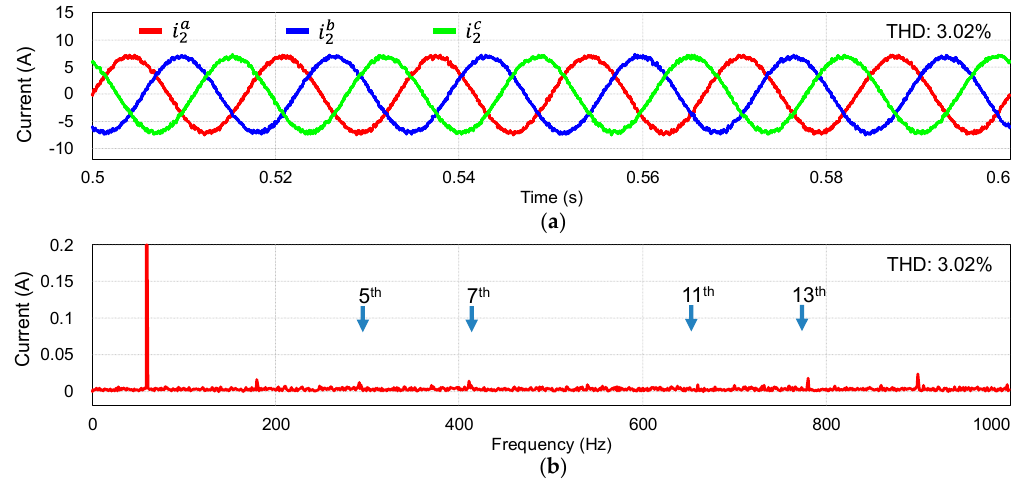
Figure 9. Simulation results of the proposed controller under the LCL filter parameter variations: The filter capacitance C f decreases from 4.5 μ F to 3 μ F . ( a ) Three-phase grid currents; ( b ) FFT result of phase- a current.